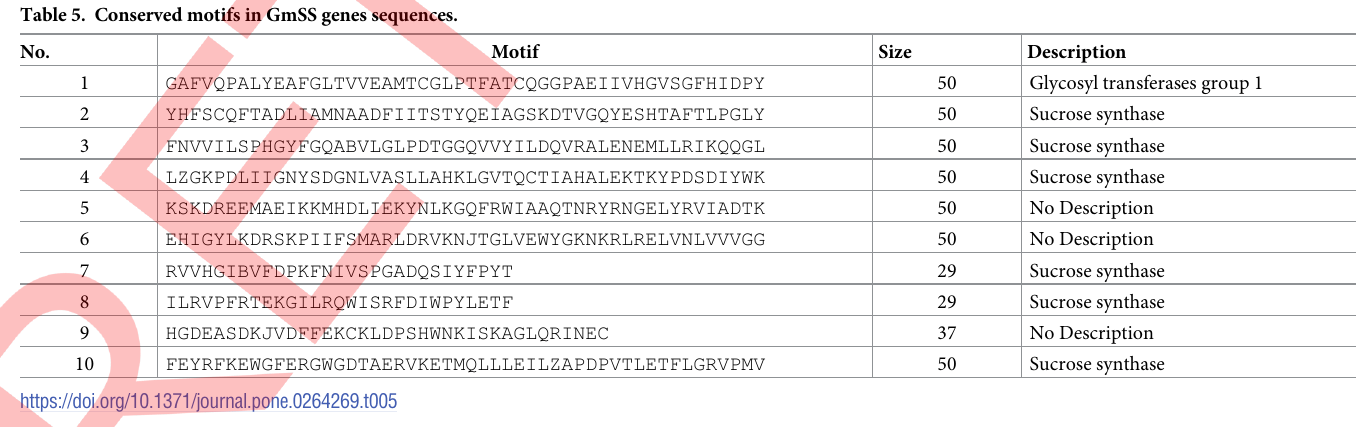
members of class II except for GmSS11 and all the members of class III did not change signifi- cantly or had very low FPKM values (S3 Table in S1 File). These results suggest that GmSS class I may have positive role in tolerance of soybean response to low pH.